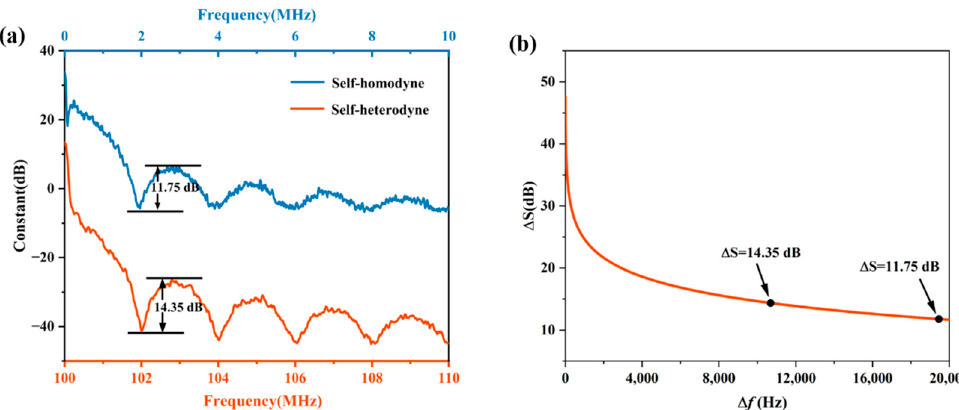
Figure 7. Plots of experimental data comparing signal measurement results taken from a commercial laser (RIO0175-5-07-1) obtained using the self-heterodyne and self-homodyne setups. ( a ) Plots of the signal PSD. ( b ) Plots of the difference in extrema amplitude (difference between the maxima and minima values) as a function of the theoretical linewidth of the laser for the extrema closest to the center frequency.